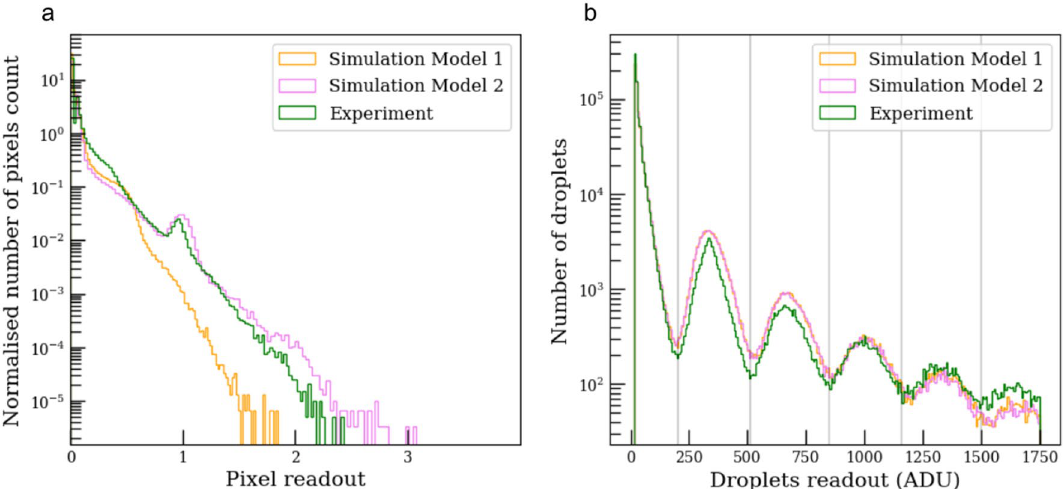
Figure 5. Pixel and droplet histogram for a 1000 experimental and simulated images with the same photon 0.025, 0.25 average ¯ k and noise readout. ( a ) CCD pixel histogram. Orange and pink are simulations with a = [ ] fixed and variable photon cloud size. ( b ) Droplet histogram in ADU with peaks corresponding to multiples of a single photon. The vertical lines define the boundaries of the integer number of photons within the droplets, with a maximum of 5 photons per droplet